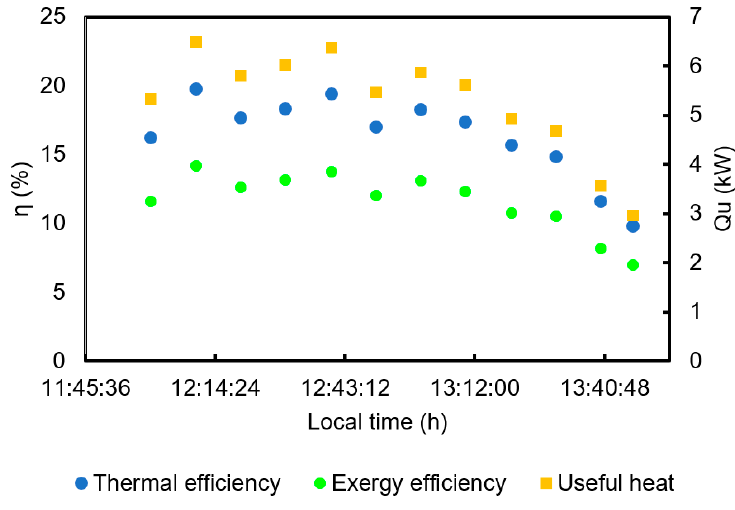
Figure 5. Thermal efficiency, exergy efficiency, and useful heat behavior, 24 November 2017.